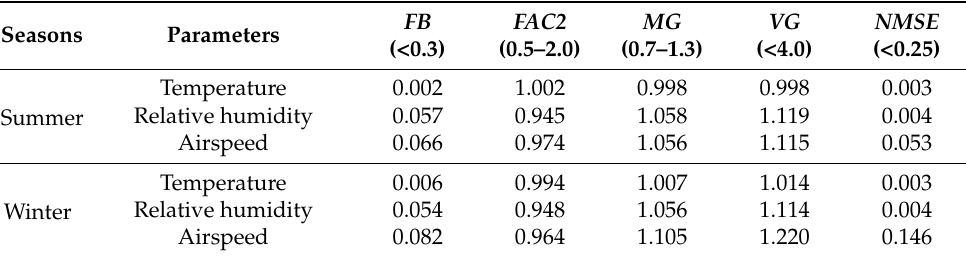
Table 4. Statistical parameters for model performance